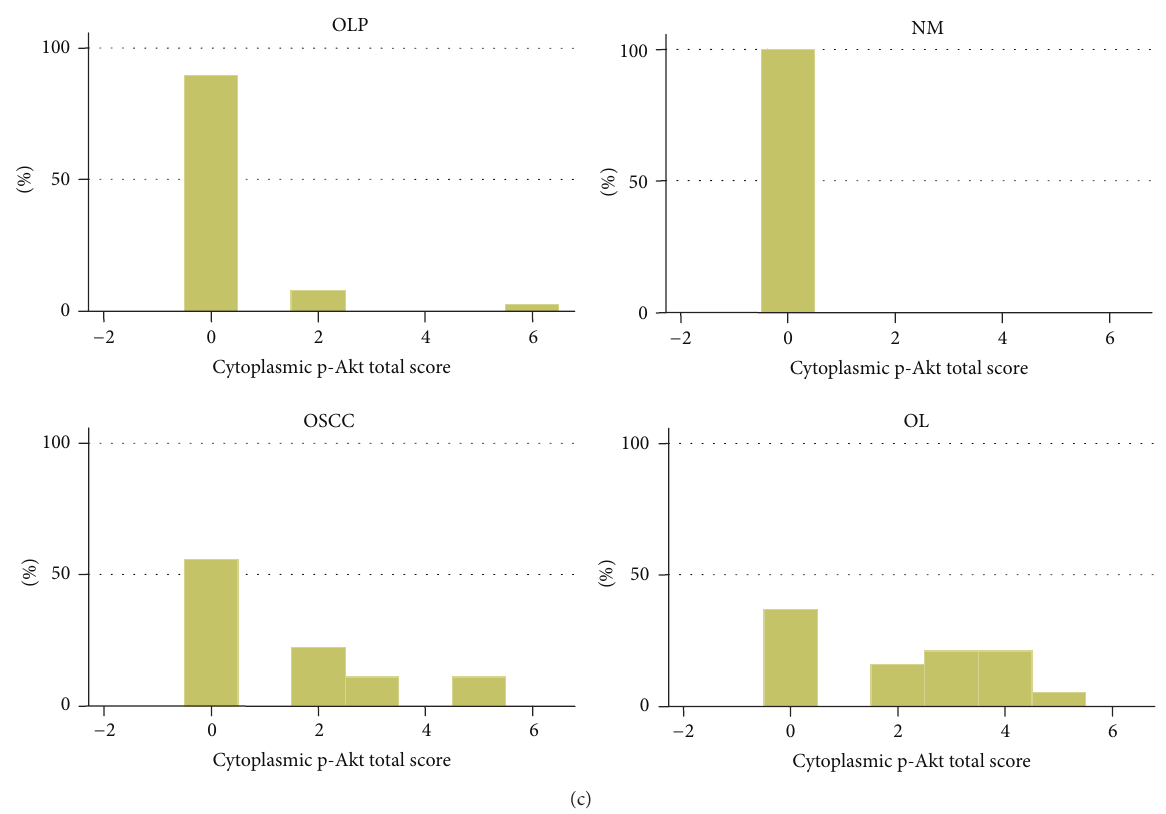
Figure 3: Graph of immunohistochemical results for cytoplasmic p-Akt. Distribution of cases per lesion category according to (a) positivity score, (b) intensity score, and (c) total score. Abbreviations: OLP: oral lichen planus; NM: normal mucosa; OSCC: oral squamous cell carcinoma; OL: oral leukoplakia. Table 3: Percentage of positive cases and average positivity, intensity, and total scores for p-mTOR per lesion category. Number and % of positive cases Average positivity score Average intensity